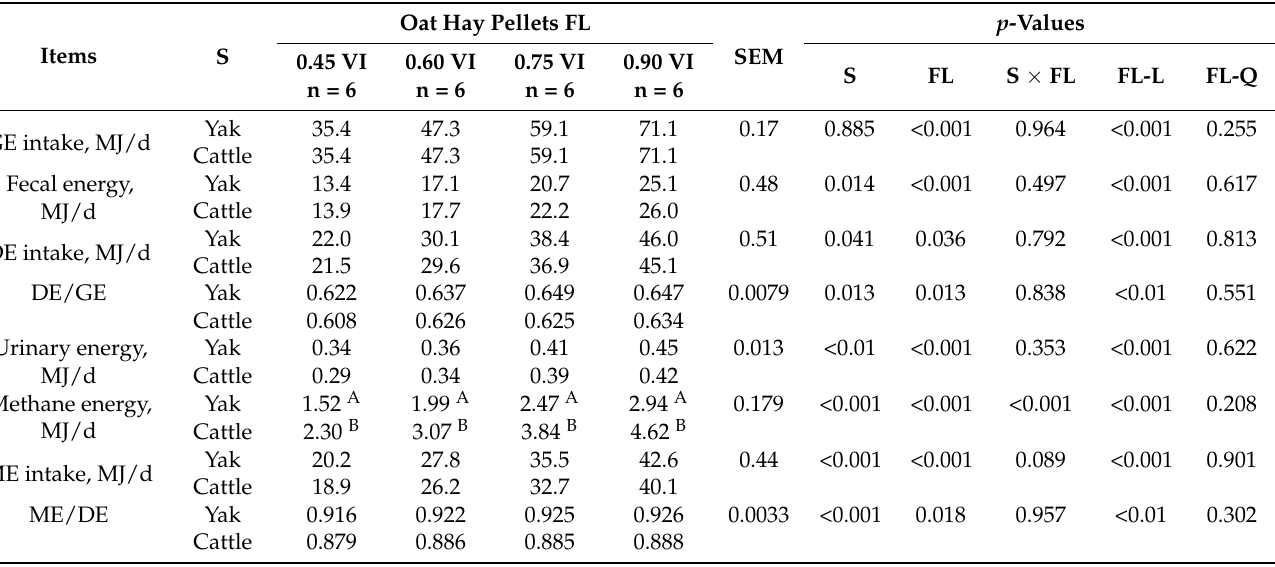
Table 3. Gross, digestible, and metabolizable energy intakes and energy output in yaks and in cattle offered oat hay pellets at different feeding